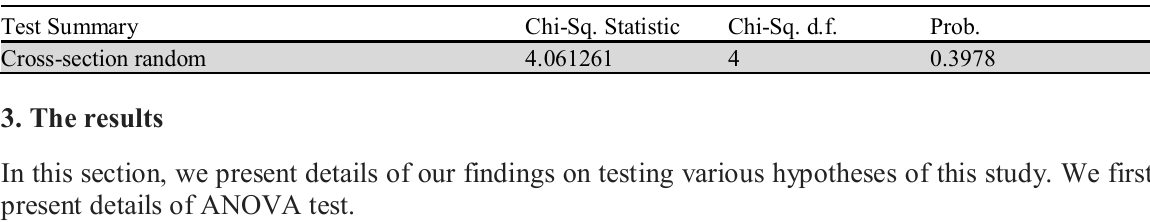
Test cross-section random